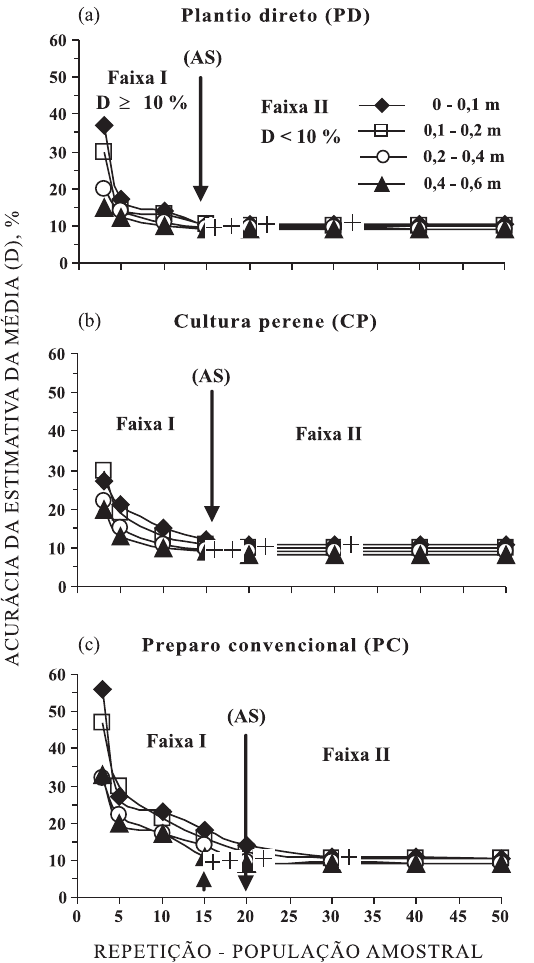
Figura 4. Acurácia da estimativa das médias de resistência do solo à penetração de um Latossolo Vermelho eutroférrico sob plantio direto (a), cultura perene (b) e sob preparo convencional (c), em função da amostragem ao acaso e da amostragem sistemática (AS;